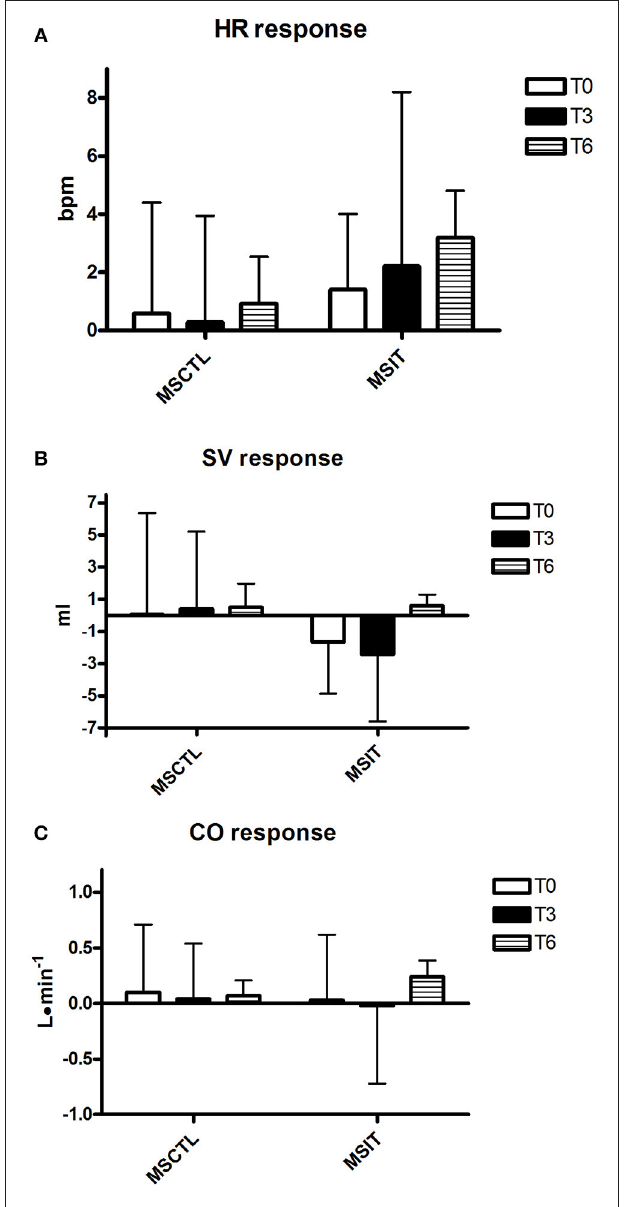
FIGURE 2 | Responses due to metaboreflex activation in HR (A) , SV (B) , and CO (C) at T0, T3, and T6, respectively. Groups are the MSCTL ( n = 10) and the MSIT ( n = 11). Values are mean ± SD.